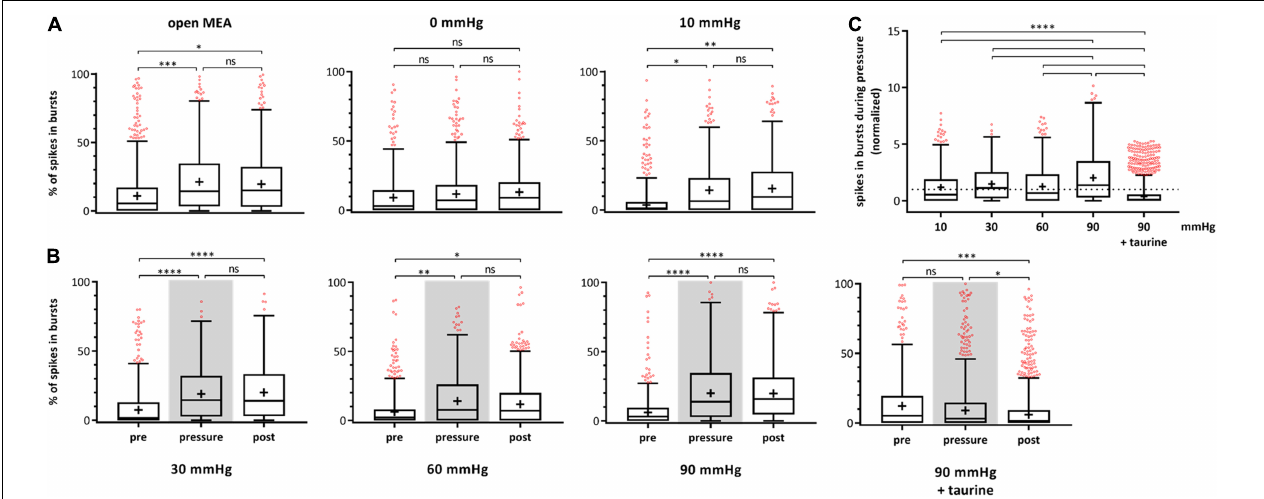
FIGURE 4 | Bursting behavior of RGCs under different pressure levels. The number of RGC spikes in bursts [%] before (pre), during (pressure), and after (post) pressure stress is shown. (A) The results of the control experiments without pressure lid (open MEA), 0 mmHg, and 10 mmHg, are presented. (B) The results of the test groups with 30, 60, 90 mmHg, and 90 mmHg + taurine (1 mM) are presented. (C) Summary of the normalized number of spikes in bursts during pressure is shown. The number of spikes in bursts before pressure (pre) was set to 1. Data are presented as box and whisker (min to max) plots. Outliers calculated by ROUT (Q = 0.1%) are shown as red circles. Mean values of the cleaned data are shown as + . Significant values are indicated by asterisks. Not significant values are labeled with ns in panels (A,B) and not labeled in panel (C) . One-way ANOVA with post hoc Tukey’s test was performed with GraphPad Prism Software version 7. (A) F (2,